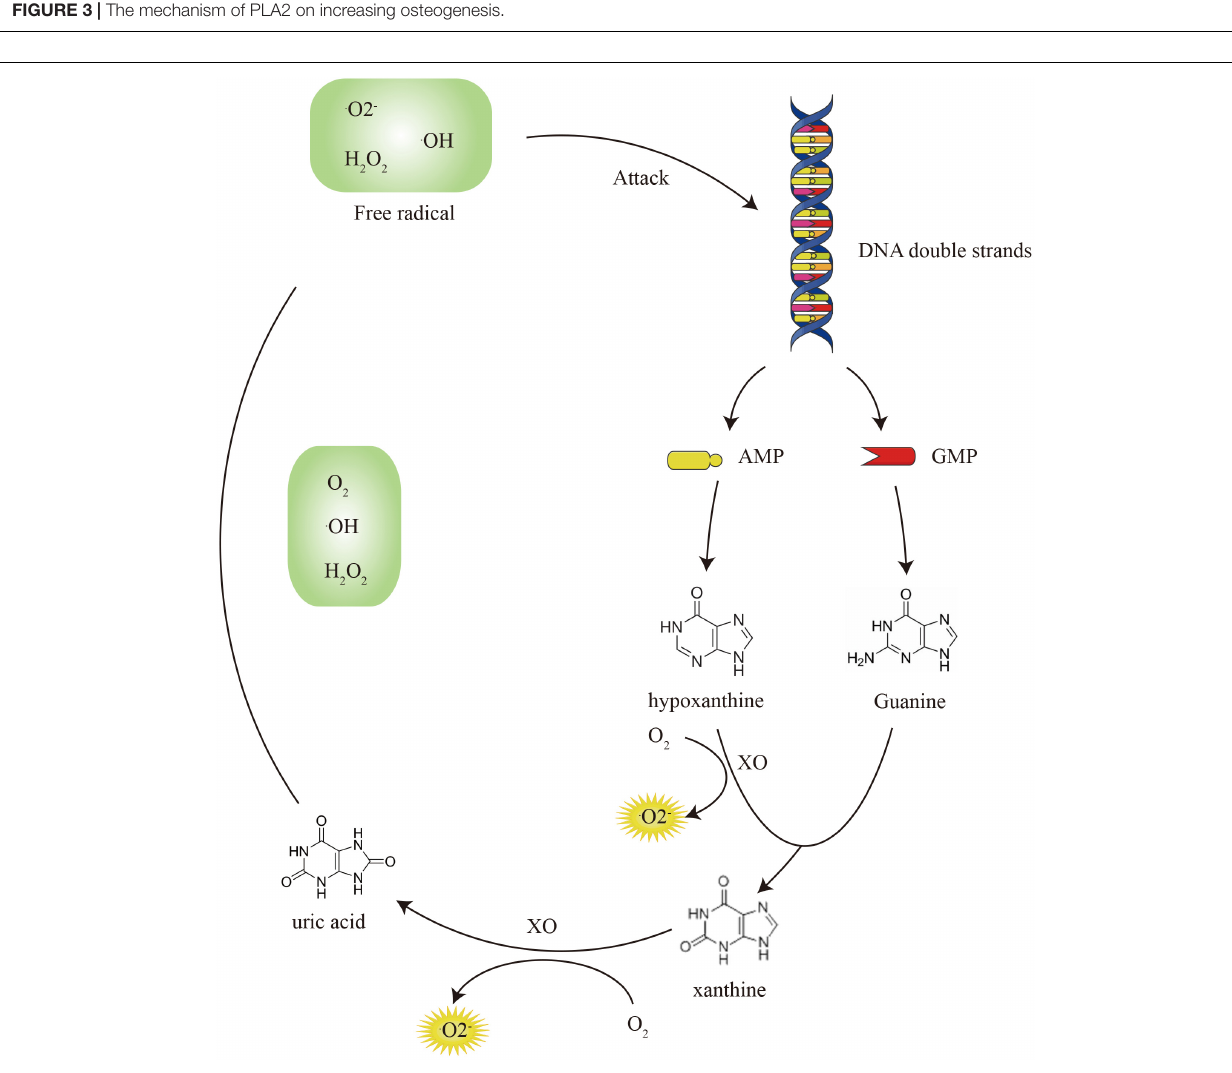
FIGURE 3 | The mechanism of PLA2 on increasing osteogenesis.